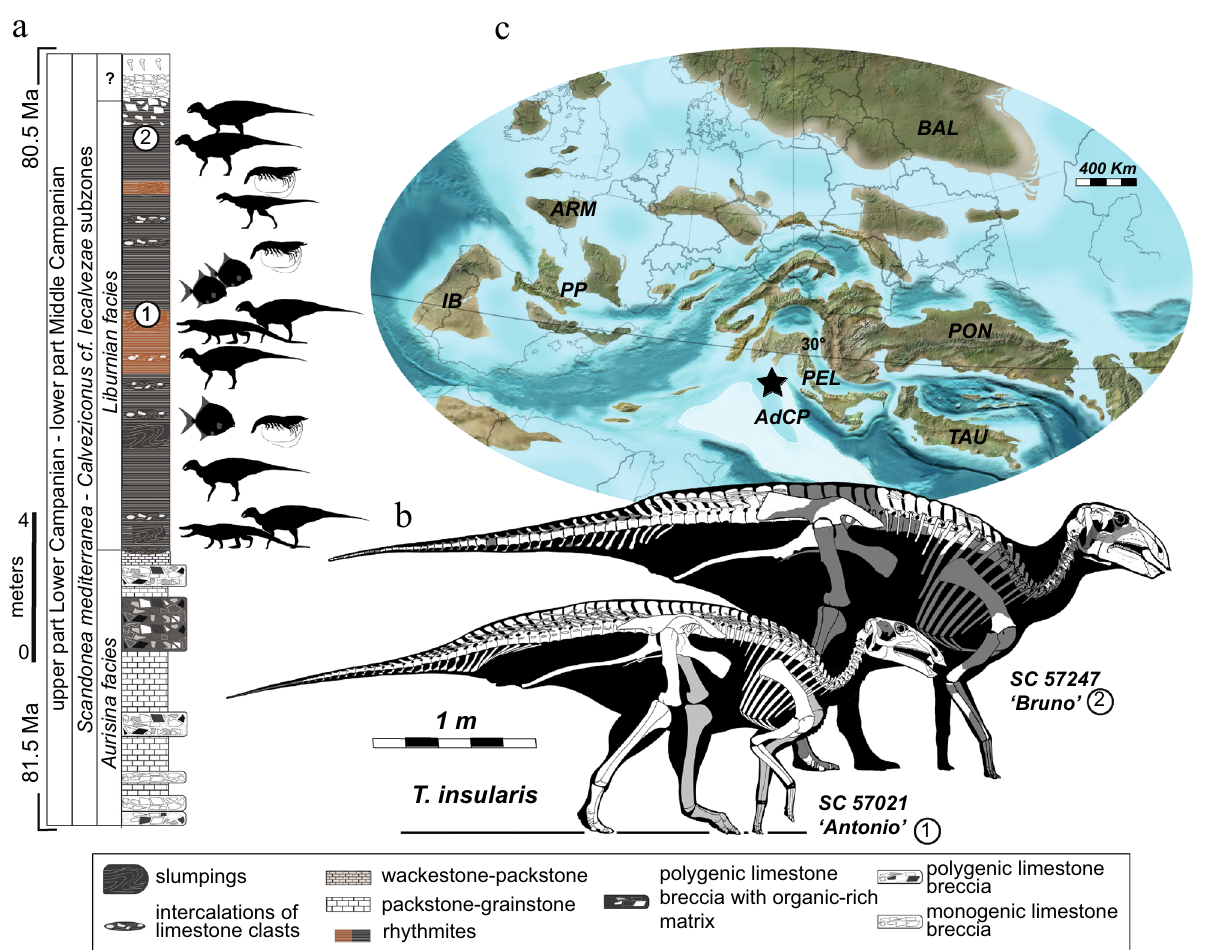
Figure 1. Geology and geographic context of Villaggio del Pescatore (VdP): chronostratigraphic context ( a ) defining the temporal setting where Tethyshadros insularis ( b ) and other fossil animals were found. Relative position (star) in the palaeogeography of the Tethys ( c ) where VdP most likely originated. Palaeogeographic abbreviations: IB, Iberian Landmass; ARM, Armorican Massif; PP, Pyrenean-Provencal Landmass; AdCP, Adriatic-Dinaric Carbonate Platform; PON, Pontides Orogen; TAU, Taurus Block; BAL, Baltic Landmass. White coloured bones in SC 57247 (b) are those recovered in the fossil and which we were able to base the reconstruction on (e.g. the outline of the sacral neural spines is based on SC 57021). Source map © 2020 Colorado Plateau Geosystems Inc. Silhouette credits: Tethyshadros —Marco Muscioni (CC-BY 4.0); Aucasaurus garridoi and Brachychampsa —Scott Hartman/Phylopic (CC-BY-NC-SA 3.0); Proscinetes elegans Dean Schnabel/ Phylopic; Penaeus —Christoph Schomburg/Phylopic (CC0